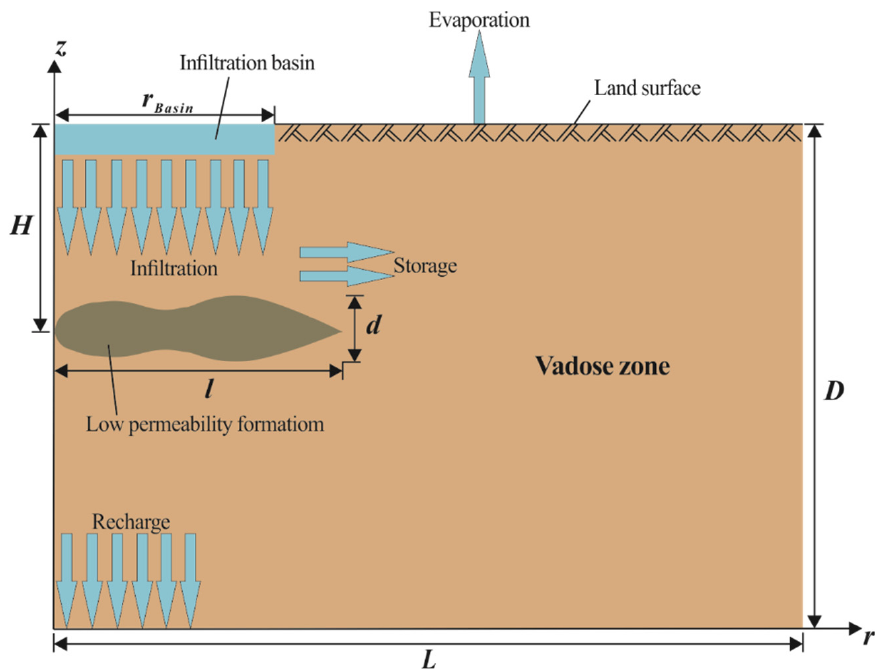
Figure 1. The conceptual sketch of a vadose zone and the water distribution from infiltration ba-